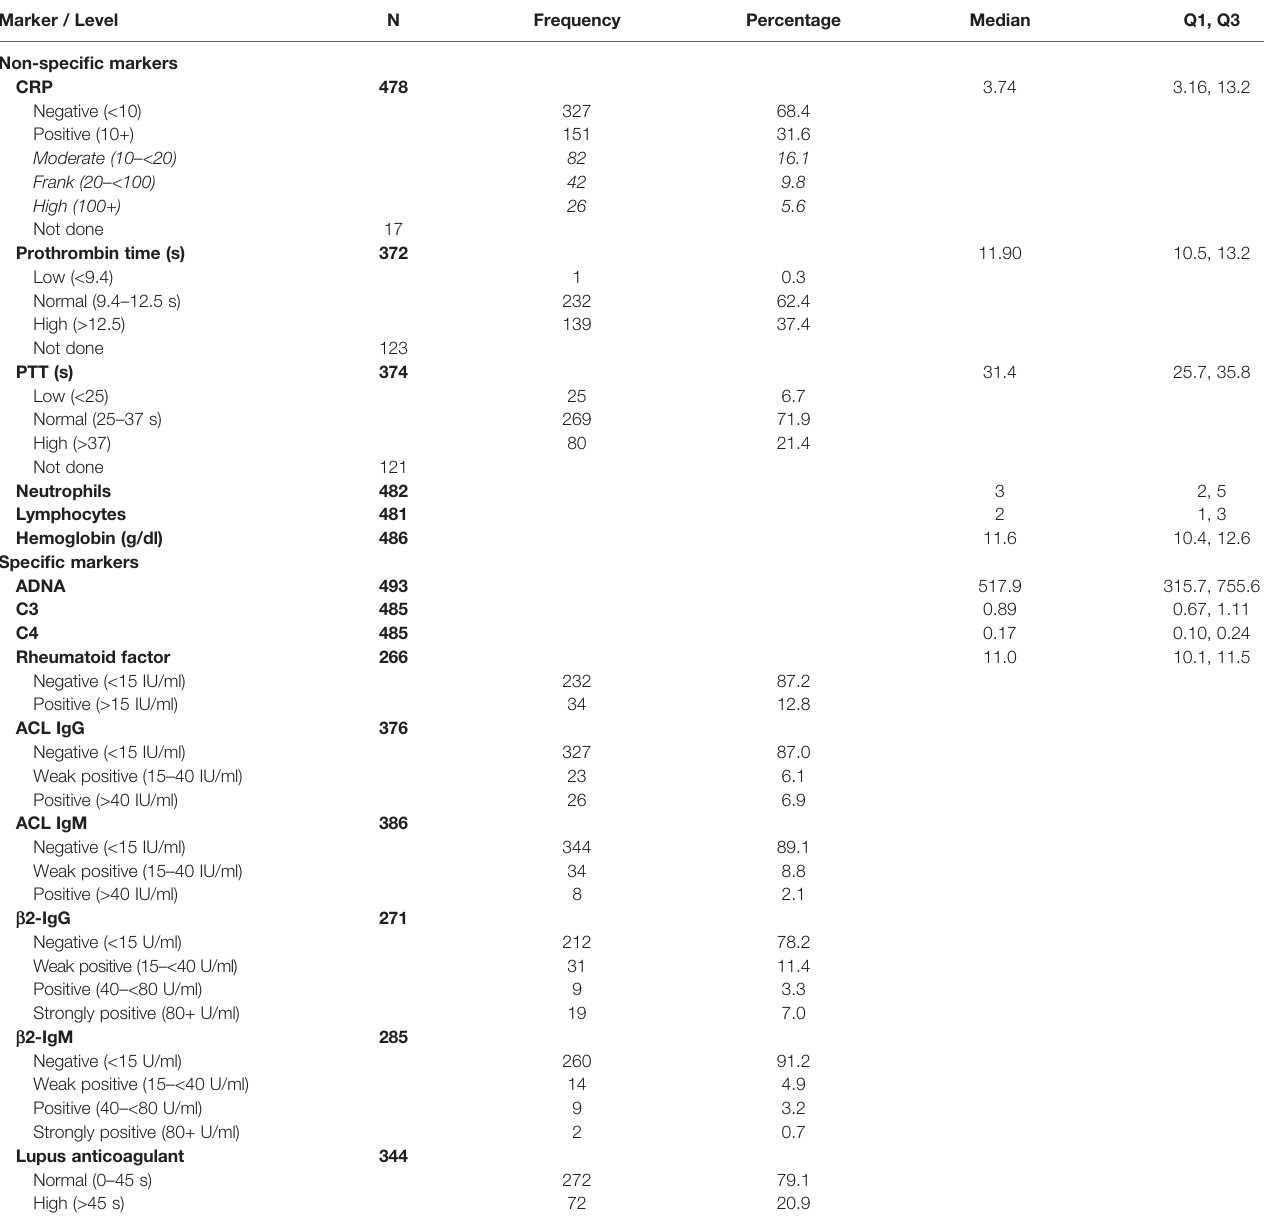
TABLE 2 | Participants ’ speci fi c and non-speci fi c biological markers. Marker /